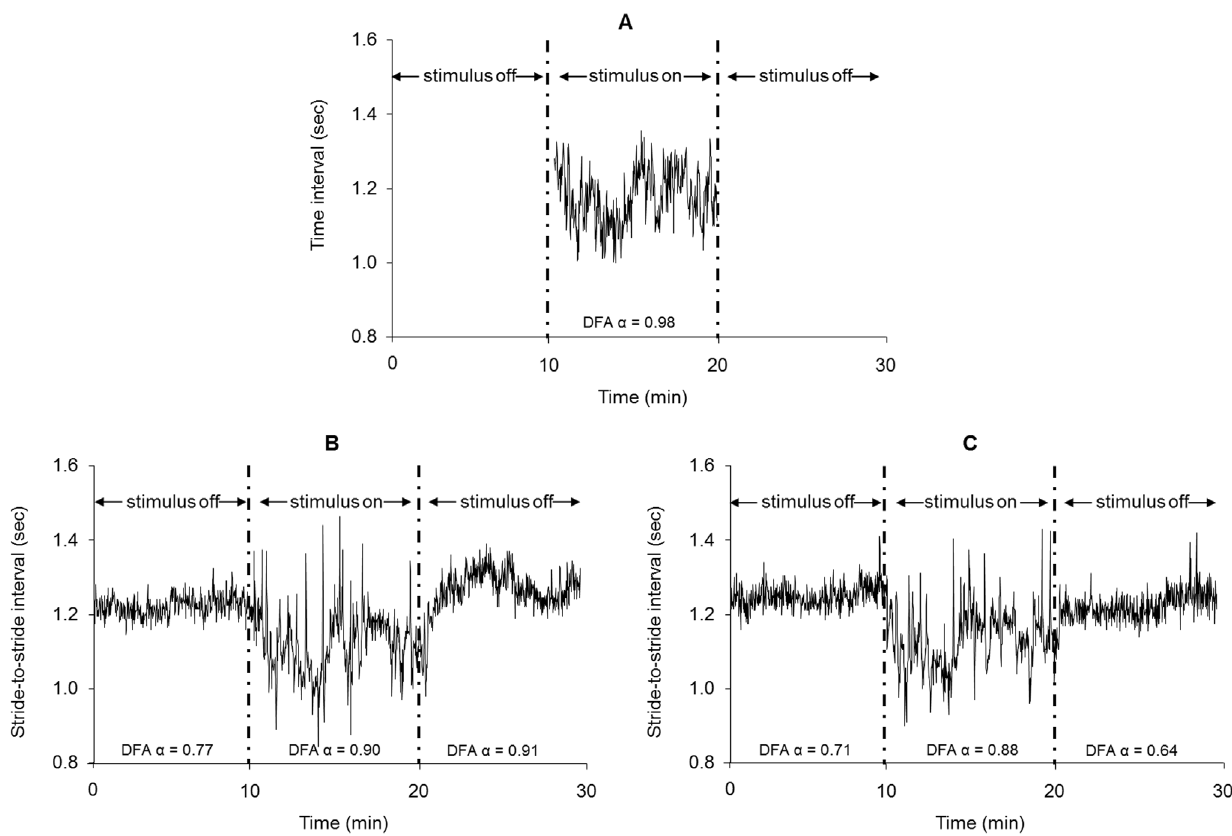
Figure 6. Time series of the stimulus and stride intervals in Experiment 2. The fractal time series used to drive both stimuli (A) and one participant’s stride interval time series before, during, and after synchronizing with the discrete stimulus (B) and the continuous stimulus (C). DFA a increased in the synchronization phase with both stimuli, but only remained elevated in the post-synchronization phase when the discrete stimulus was